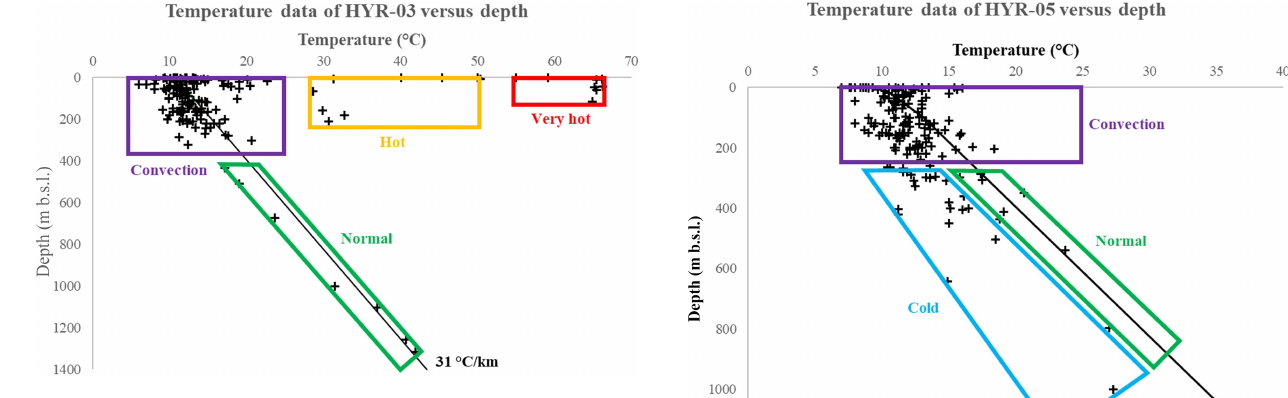
Figure 3. Temperature data of HYR-03 plotted against depth. While the majority of data are characterized by convection and/or follow the typical Hessian geothermal gradient (normal), two data clusters of hot and very hot groundwaters are also apparent. Note that the field convection has been constrained rather arbitrarily and is not based on firm scientific evidence.